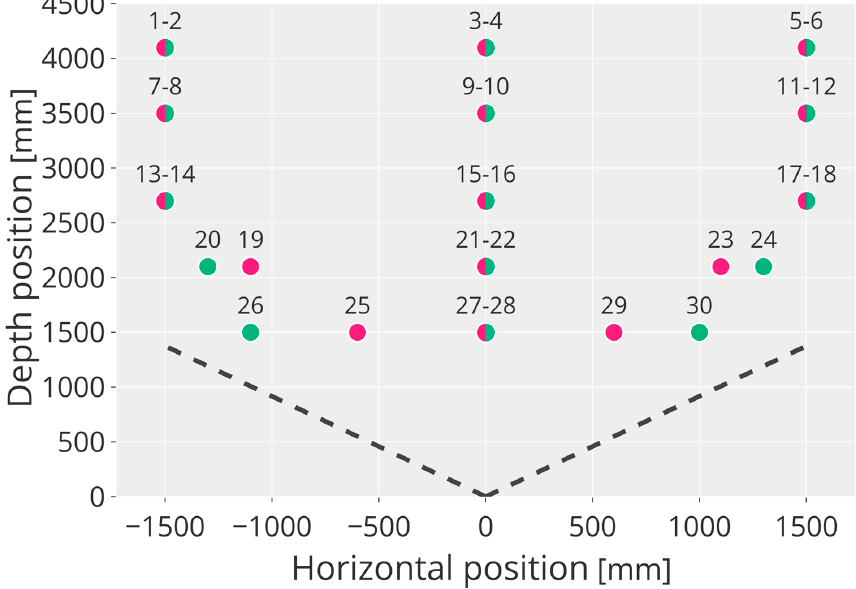
Figure 7. Cylinder positions adopted in the experiment. Red dots refer to odd station numbers, green dots to even station numbers.